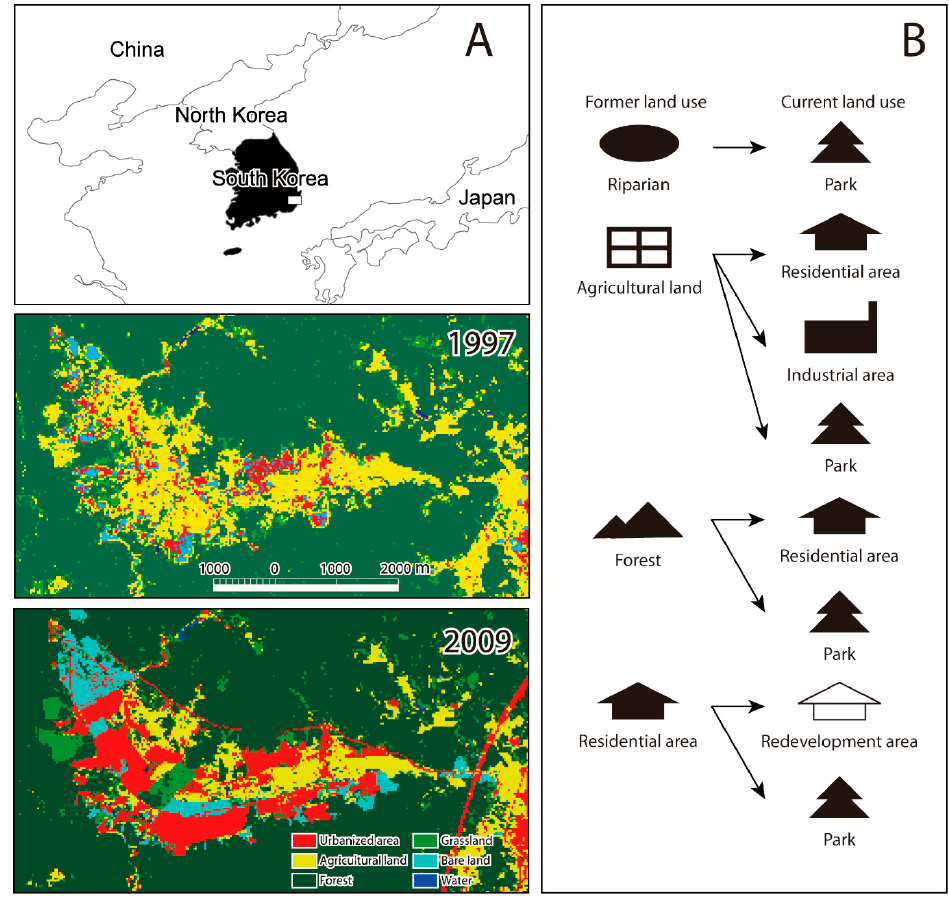
Figure 1. ( A ) Map of study area showing the conversion of land-use after new town development. Most bare land and agricultural land in 2009 were also converted to residential and commercial areas; ( B ) scheme showing the modification from former to current land-use types.